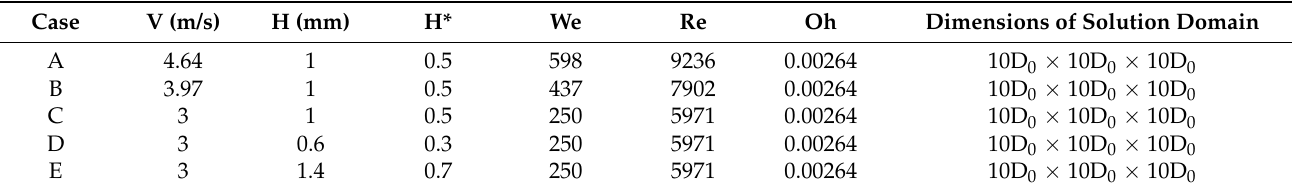
Table 2. Simulated operating condition